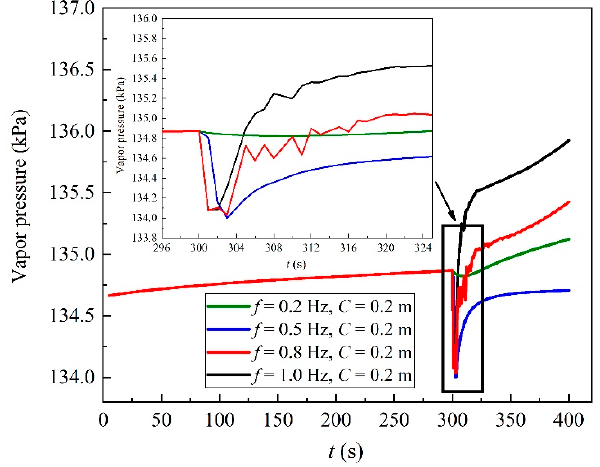
Figure 13. Variation of vapor pressure under different sloshing frequencies.